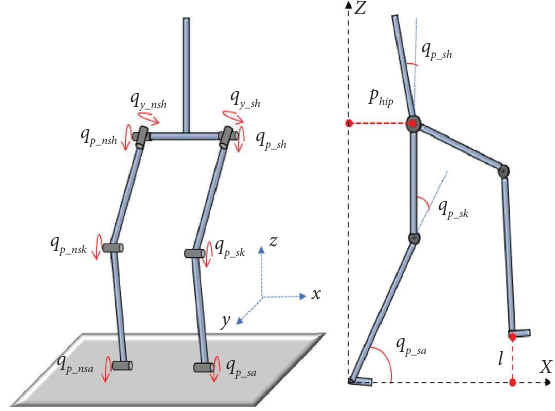
Figure 3: Joint representation. Table 1: